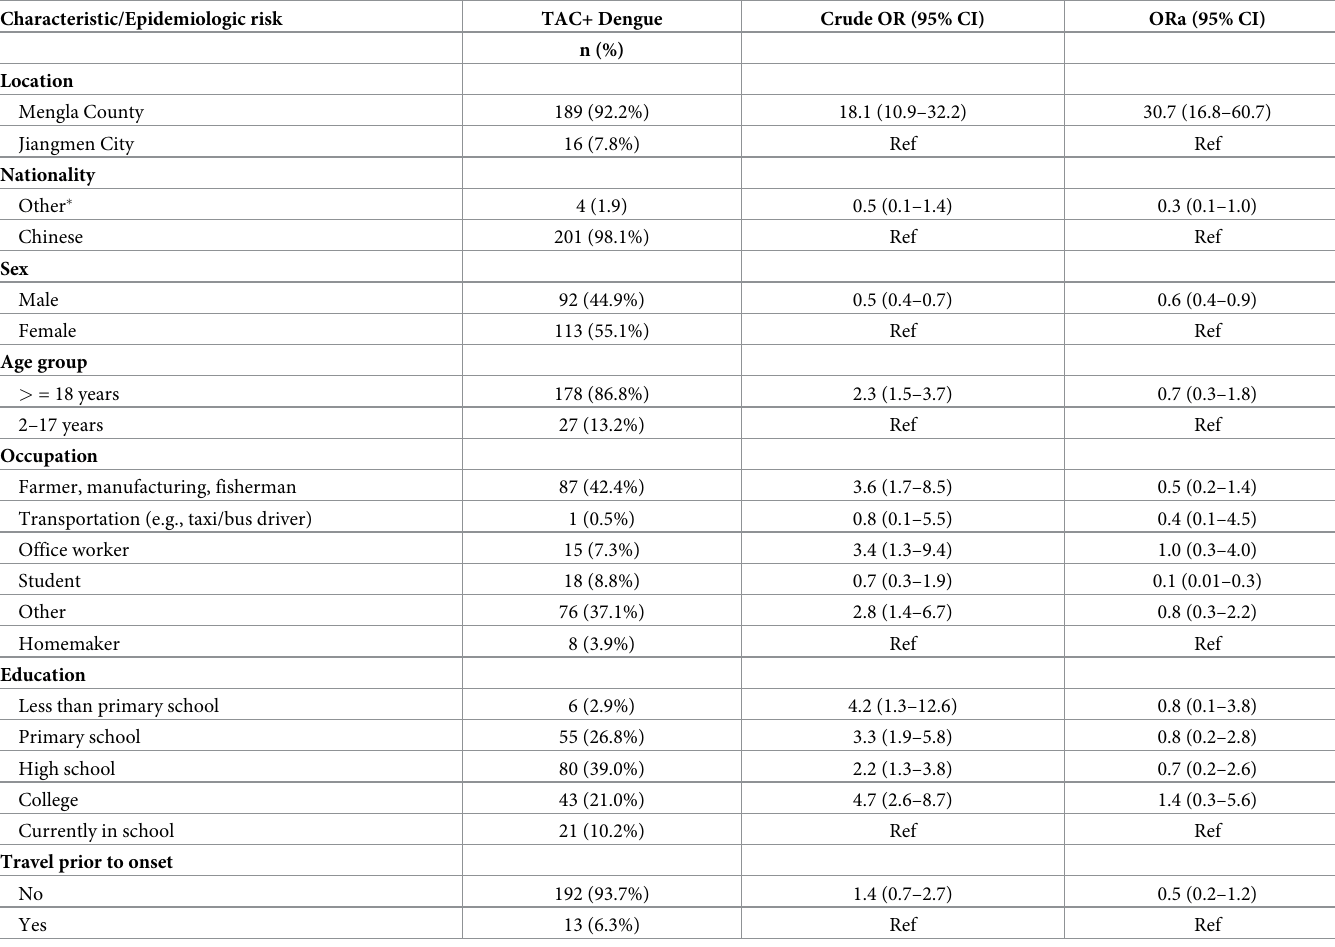
Table 4. Association between patient characteristics/epidemiologic factors and detection of dengue on the TaqMan Array Card (TAC) � diagnostic testing platform, China, June 2017–July